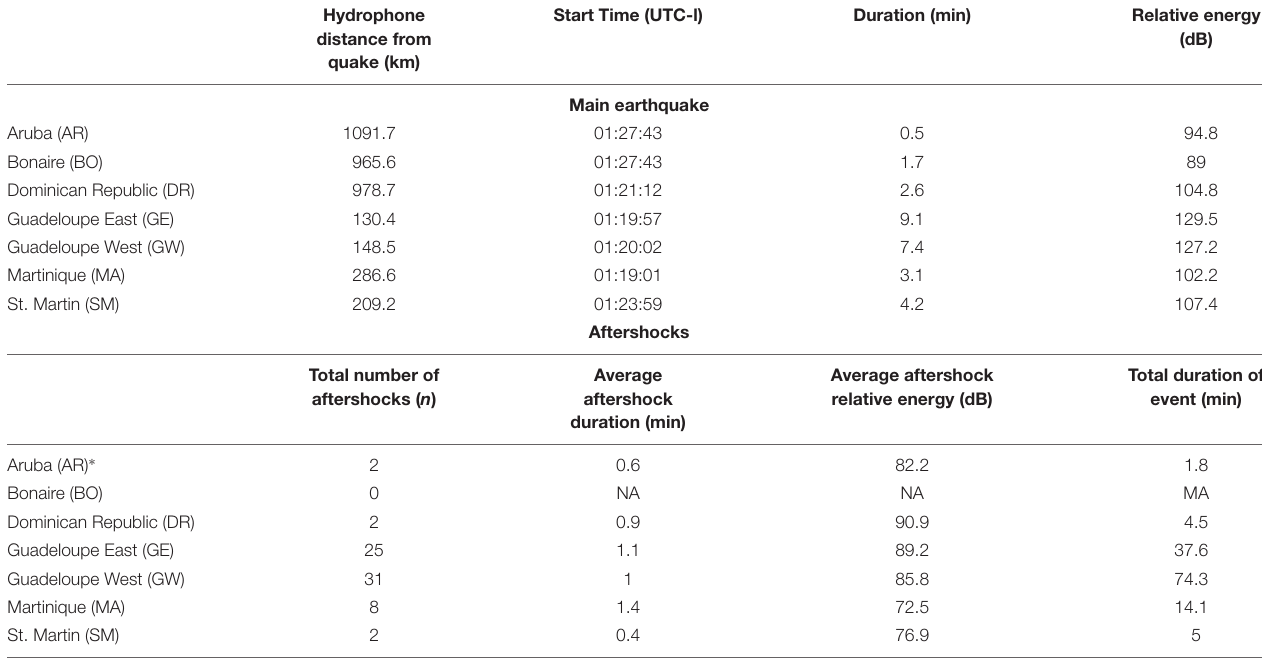
TABLE 3 | Summary of 17 April 2017 earthquake and aftershock